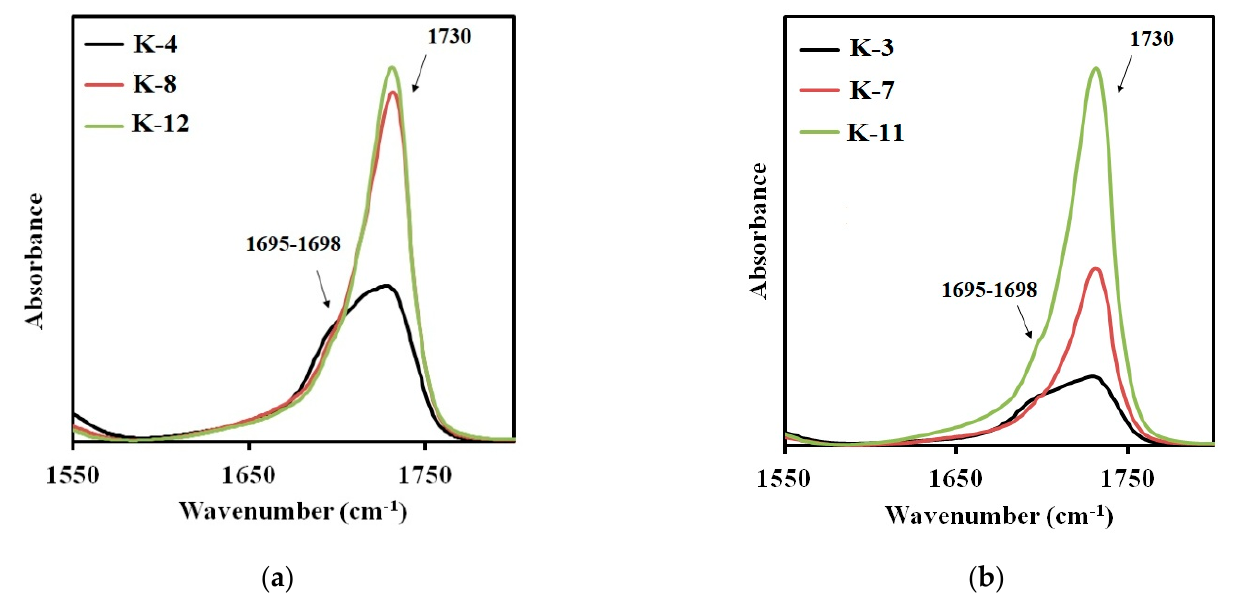
Figure 8 . Sections of the FTIR spectra for the samples: ( a ) K–4, K–8, K–12; ( b ) K–3, K–7, K–11.